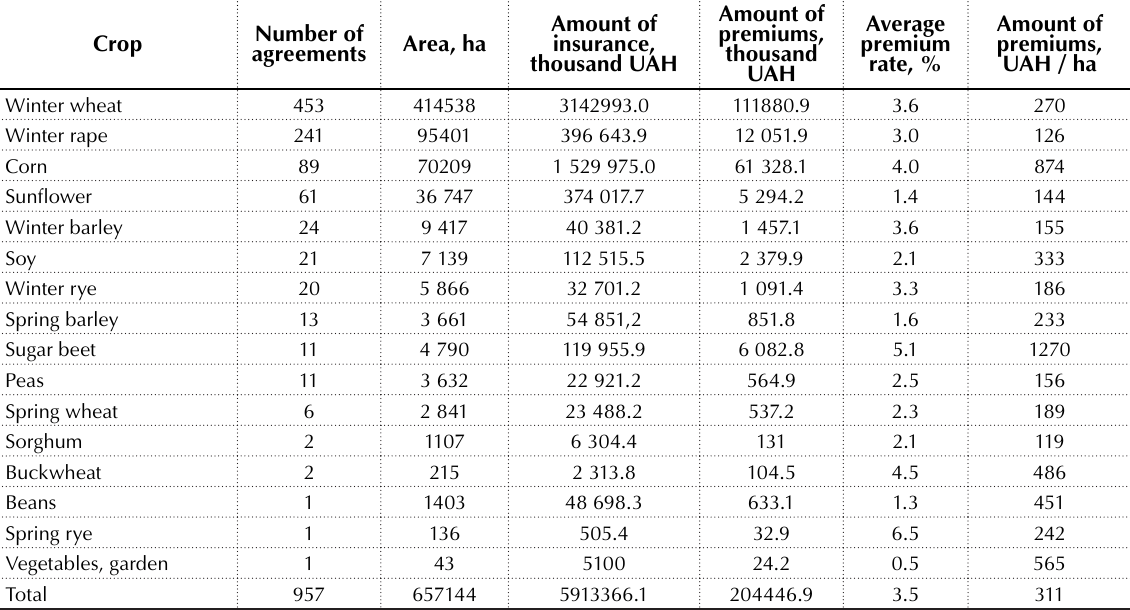
Table 1. Consolidated insurance data in the context of agricultural crops,